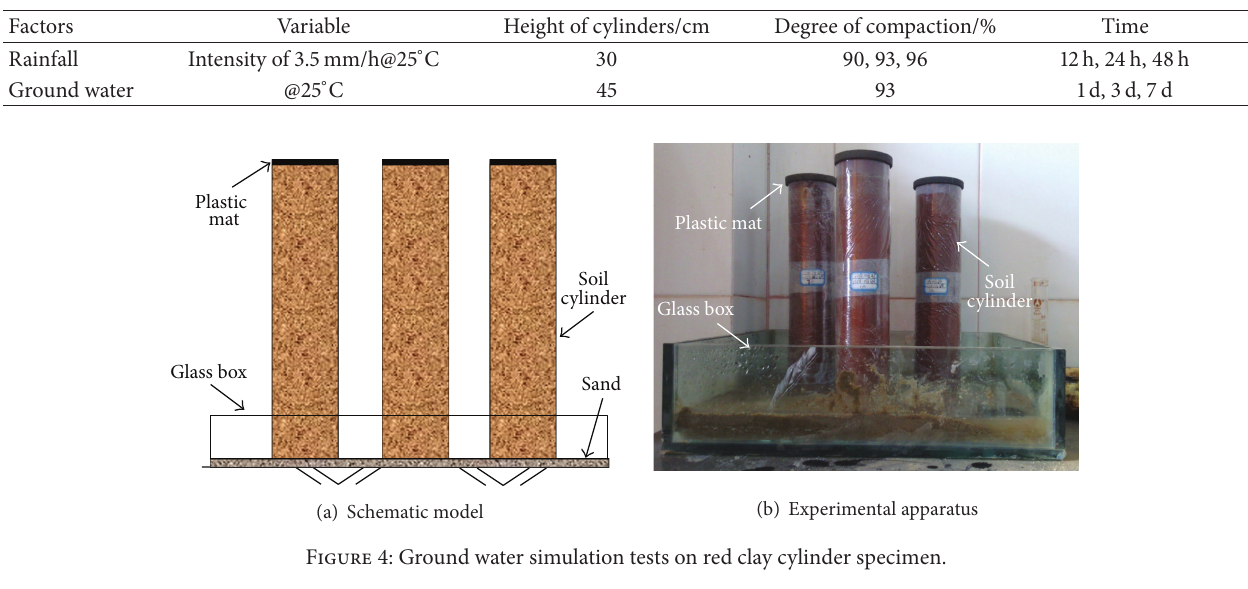
Table 2: Details of test parameters.